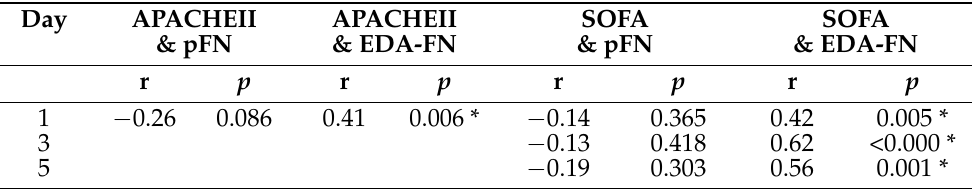
Table 2. Spearman’s rank correlation coefficient between pFN, EDA-FN and the APACHE II score calculated on admission to the ICU and between pFN, EDA-FN and the SOFA score calculated on admission, day 3 and 5.